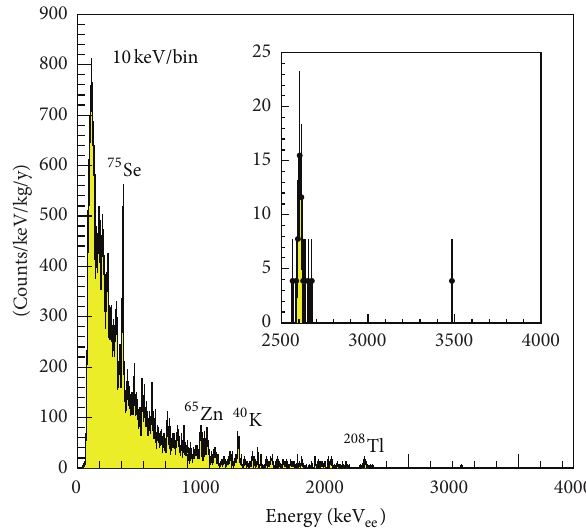
Figure 5: 524 h background run performed with a 431g ZnSe crys- tal. Energy spectrum of 𝛽/𝛾 events. Data are calibrated using 𝛾 - sources. In the inset the magnification of the high energy